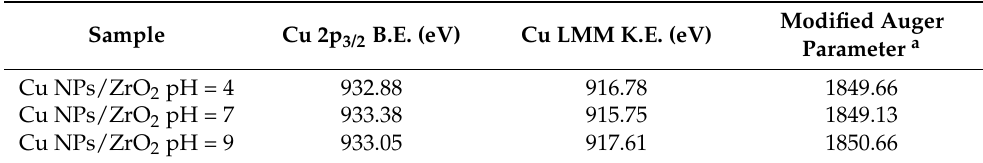
Table 4. Cu 2p 3/2 binding energy, Cu LMM kinetic energy and Auger